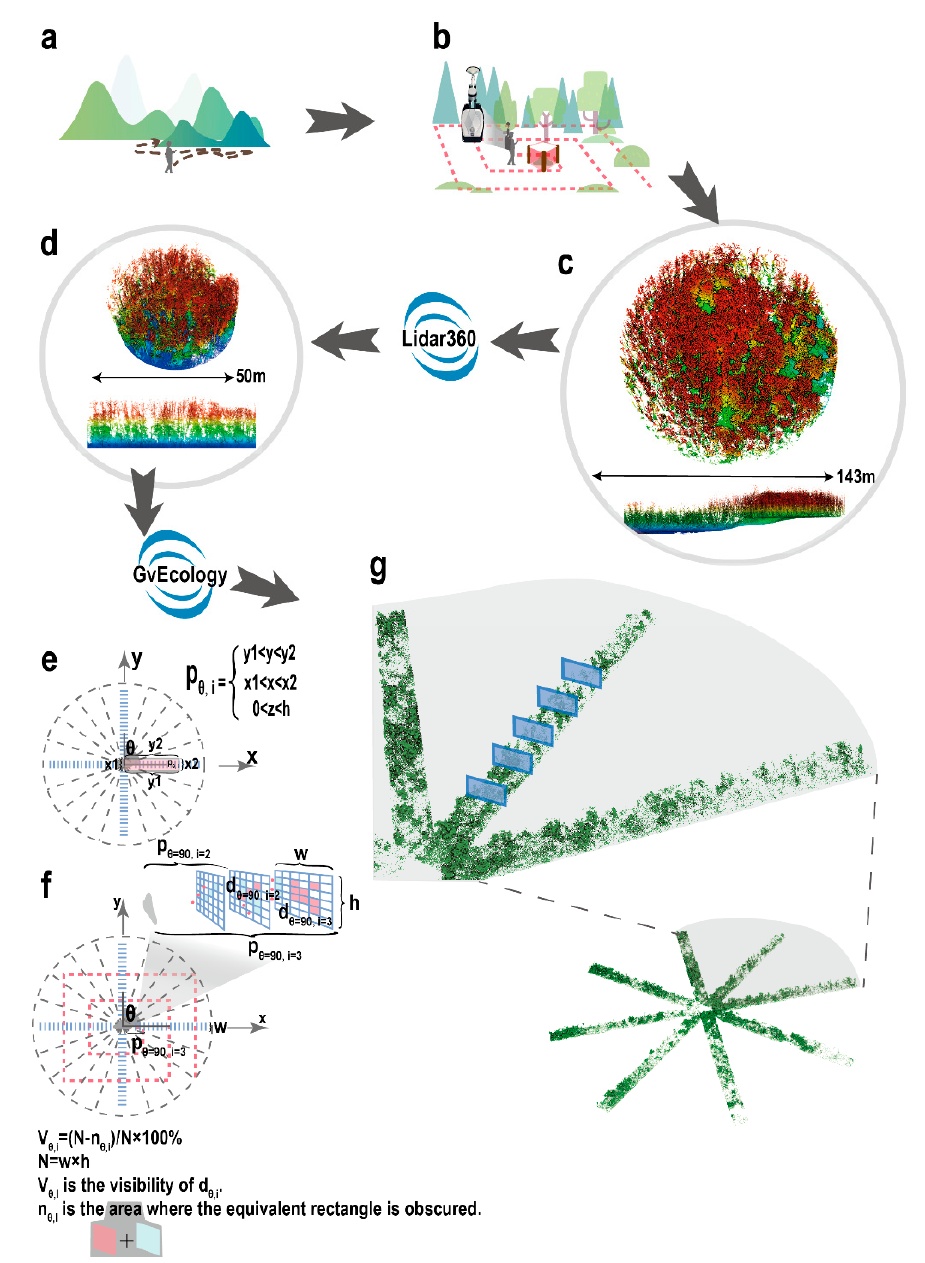
Figure 2. Workflow of the research framework. ( a ) Initial field survey to obtain the location of wild boar nests. ( b ) Point cloud data collection. The red cube is an artificial fence that represents the location of the wild boar’s nest to accurately identify it when processing the point cloud data. The red line is the trajectory when the point cloud data are collected by backpack laser scanning (BLS).This trajectory can improve the consistency of point cloud data with real things. ( c , d ) LiDAR 360 was used to preprocess point cloud data. ( c ) Original point cloud data. The range is larger than the sample range, and the lowest point cloud is not on the same horizontal plane. ( d ) Pre-processed point cloud data. The sample range is a circular area with the wild boar’s nest as the center and a radius of 25 m. The lowest point cloud is in the same horizontal plane. ( e , f ) Calculation of the visibility using the minimum enclosing rectangle ( e ), and positioning of the minimum enclosing rectangle to simulate the tiger near the nest ( f ), using GvEcology. We set up a minimum enclosing rectangle in 1–360 directions ( θ ) around the nest and 39 distance gradients (i) in each direction ( θ ) ( f ). ( g ) Use of ( e – f ) with point cloud data and mapping of an actual